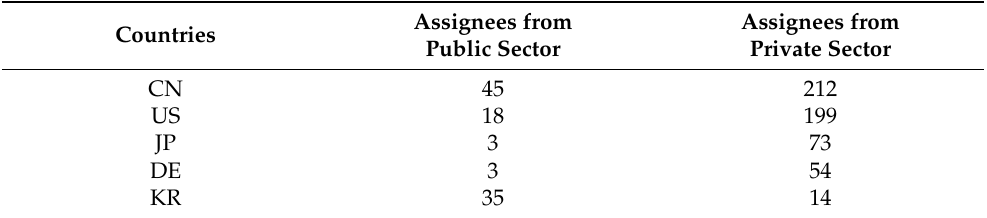
Table 1. Distribution of distinct assignee types in the top 5 countries.